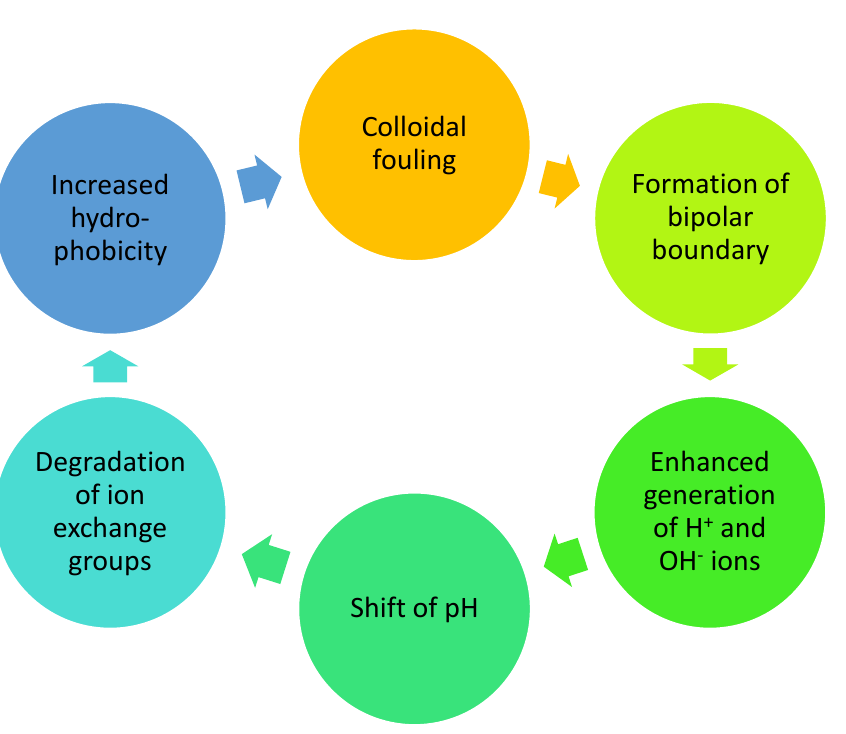
Figure 8. Example of processes of membrane degradation enhancing each other in a cycle.